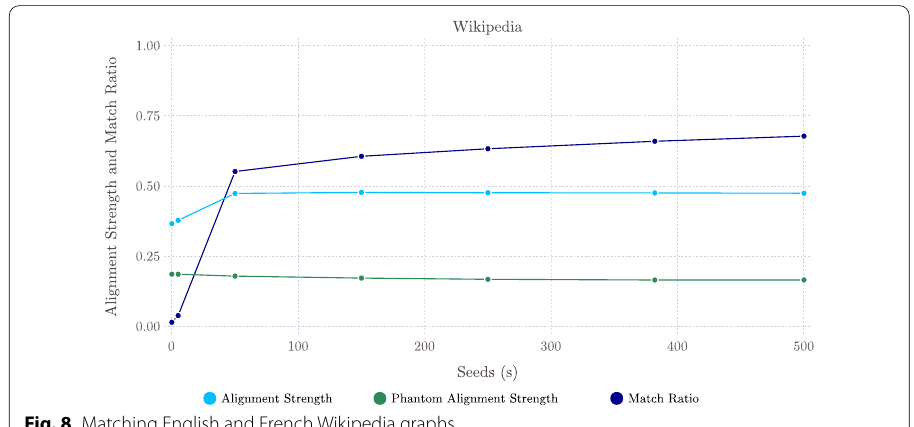
Fig. 8 Matching English and French Wikipedia